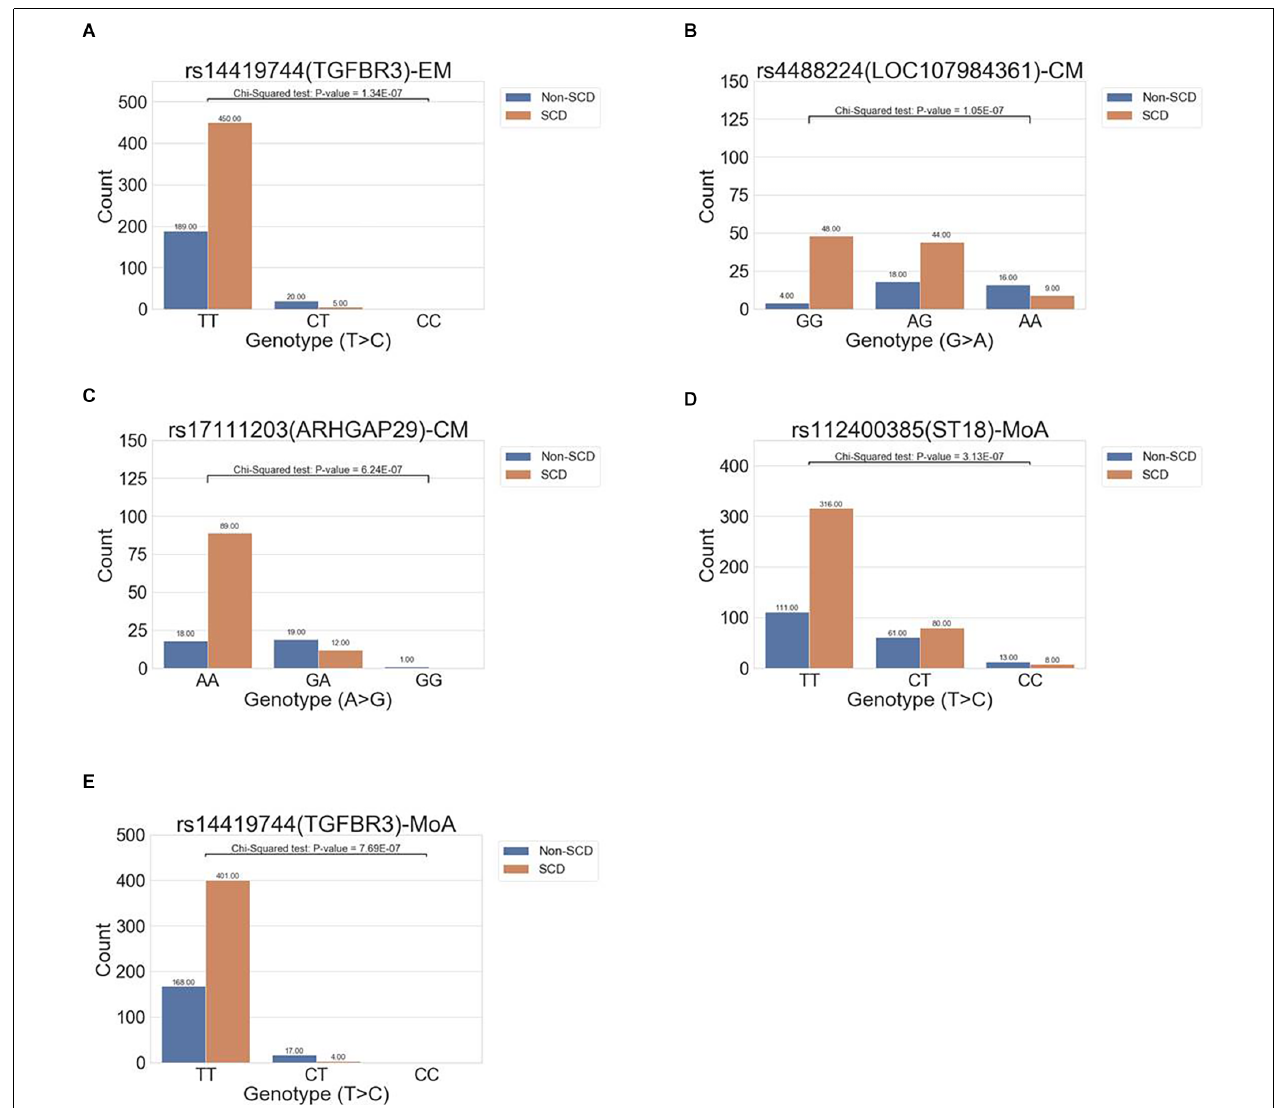
FIGURE 3 | The distribution of allele frequencies of variants across the EM, CM, and MoA subgroups. The study identified genes correlated with SCD that were associated with episodic migraine (rs14419744 in TGFBR3, A ), chronic migraine (rs17111203 in ARHGAP29, rs112400385 in ST18; B,C ), and migraine without aura